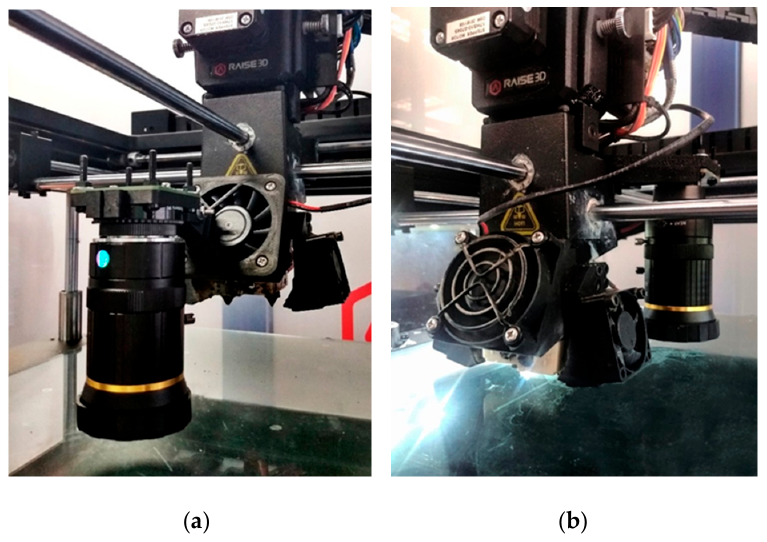
Figure 2. Integration of 3D ‐ printed customizable tools and hardware for detection (i.e., image cap ‐ turing): ( a ) Mounting Module A (frontside); ( b ) Mounting Module B (backside).